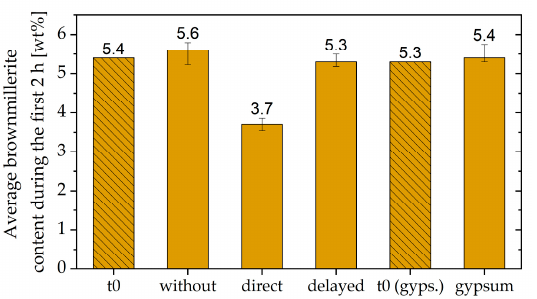
Figure 9. Average brownmillerite content during the first 2 h at the beginning of hydration (t 0 ), without SP, with direct addition of 0.7 wt% of SP, with a delayed addition of 0.7 wt% of SP, and with 2 wt% additional gypsum and direct addition of 0.7 wt% of SP .